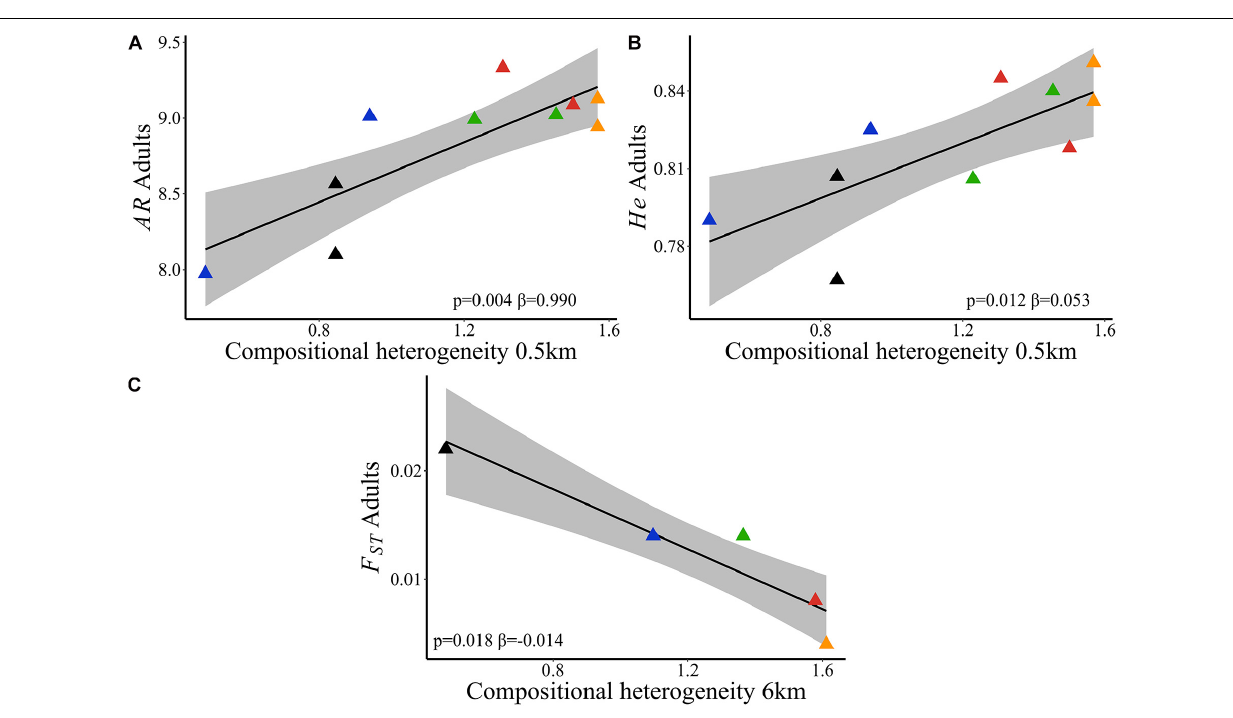
FIGURE 4 | Relationships of neutral genetic variability and landscape compositional heterogeneity (SHDI) in Caryocar brasiliense based on 10 sampling sites in the Cerrado biome, Brazil. (A) Allelic richness ( AR ) in adults and SHDI at node level. (B) Genetic diversity ( He ) in adults and SHDI at node level. (C) Genetic differentiation ( F ST ) in adults and SHDI at 6 km spatial scale. Black line is the linear regression fit and shaded area is the 95% confidence interval. Triangle color corresponds to the landscape: red = L1; blue = L2; orange = L3; green = L4; black =